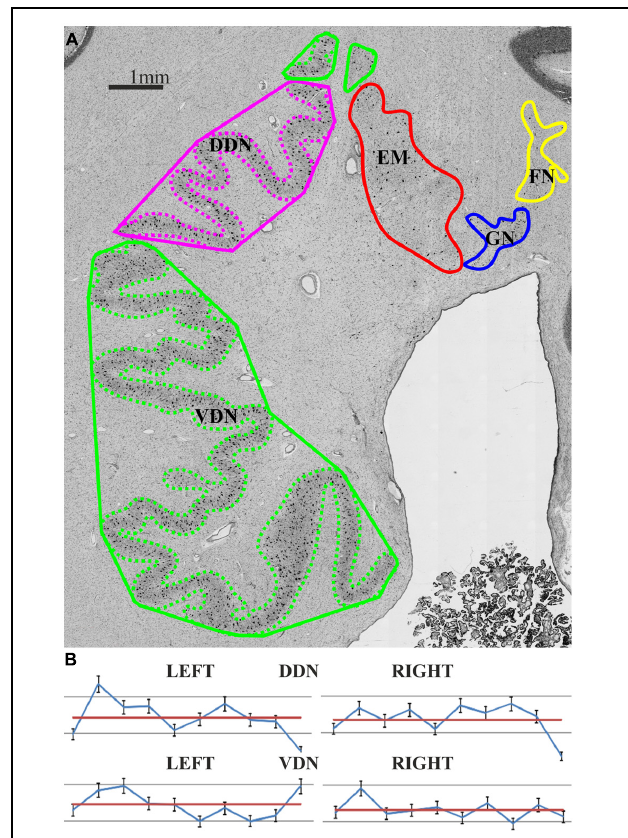
FIGURE 4 | (A) The Folding Index (FI) provides information about the gyrification and was estimated as the quotient of Length (whole contour: dashed line) per Length (hull contour: solid line). Magenta: dorsal dentate nucleus (DDN); green: ventral dentate nucleus (VDN); red: emboliform nucleus (EN); blue: globose nucleus (GN); yellow: fastigial nucleus (FN); (B) Individual FI values of each partition and hemisphere of 10 post mortem brains (blue: FI; red: mean